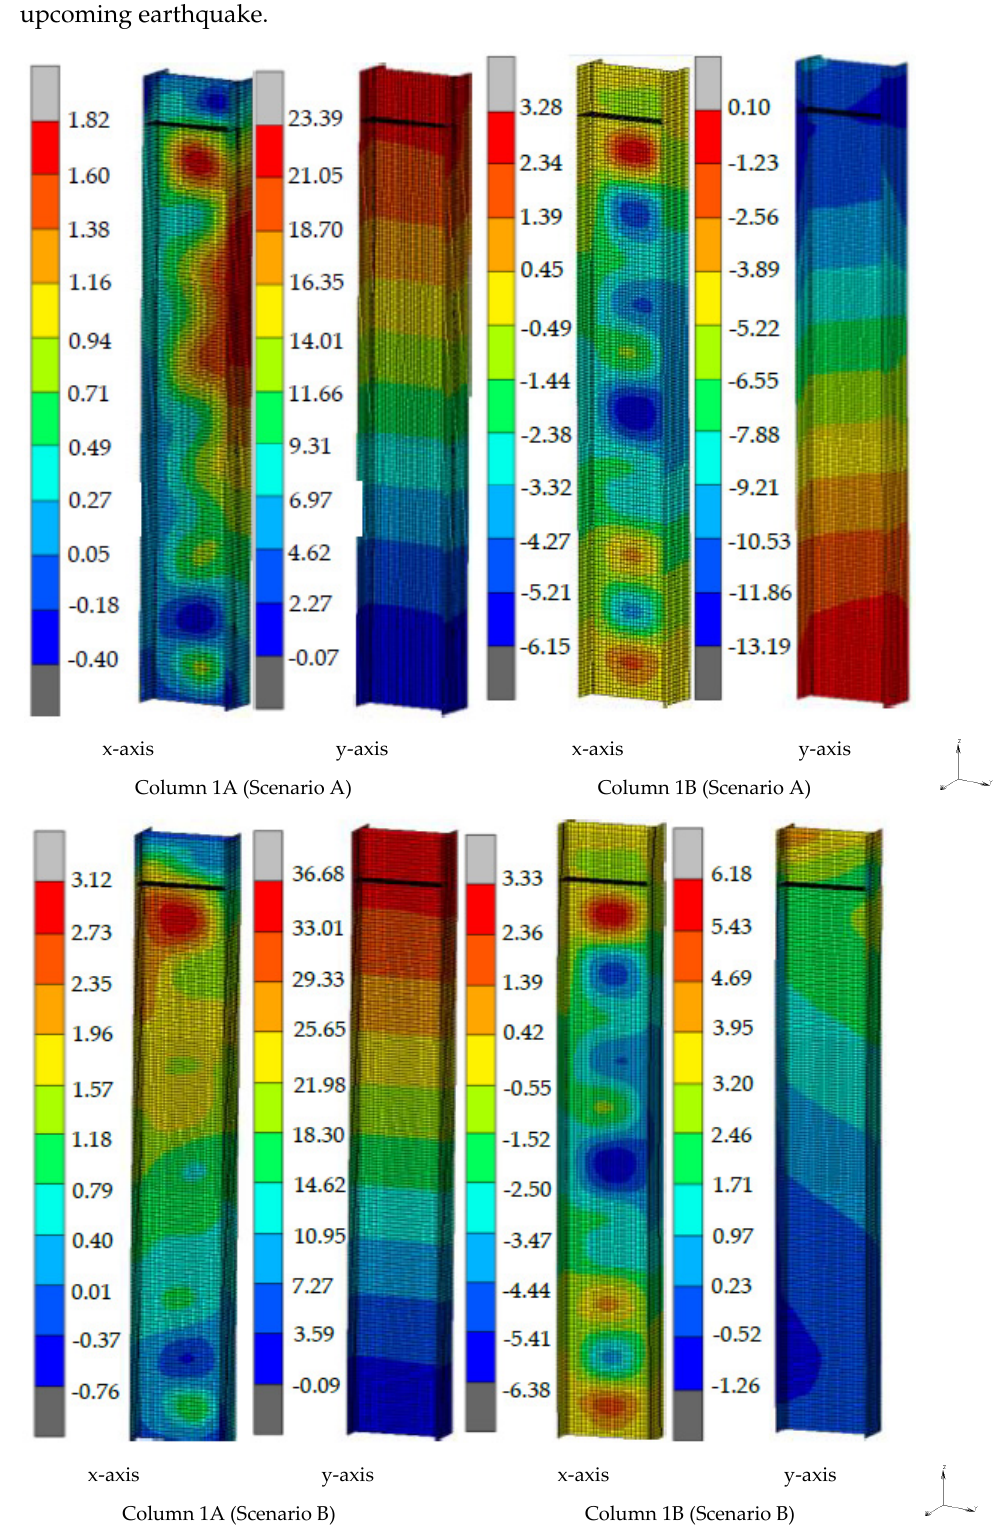
Figure 22. Displacement field (in mm) and deformed configuration of the heated